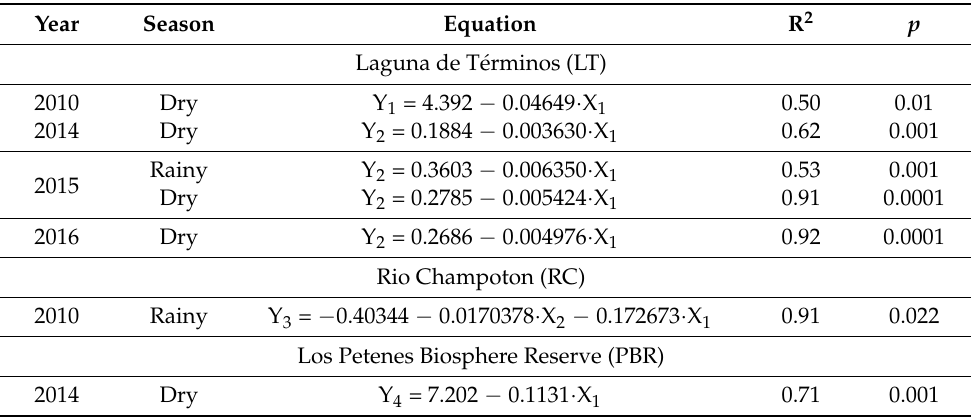
Table 8. Linear and multiple regression analysis of pore water physicochemical parameters, precipitation, and phenological characteristics in three mangrove forests of Rhizophora mangle along the coast of